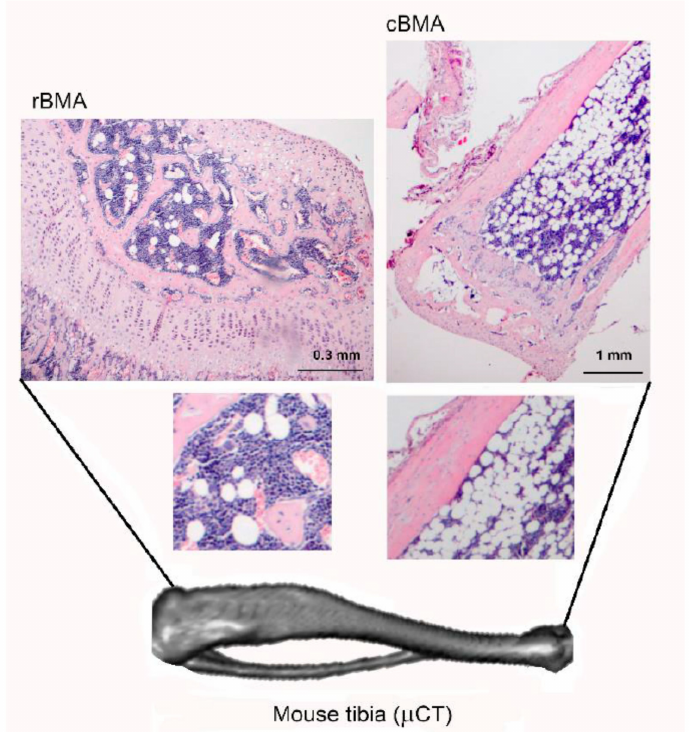
Figure 1. Distribution of regulated (rBMA) and constitutive (cBMA) bone marrow adipocytes in the mouse tibia. Original figure courtesy of the